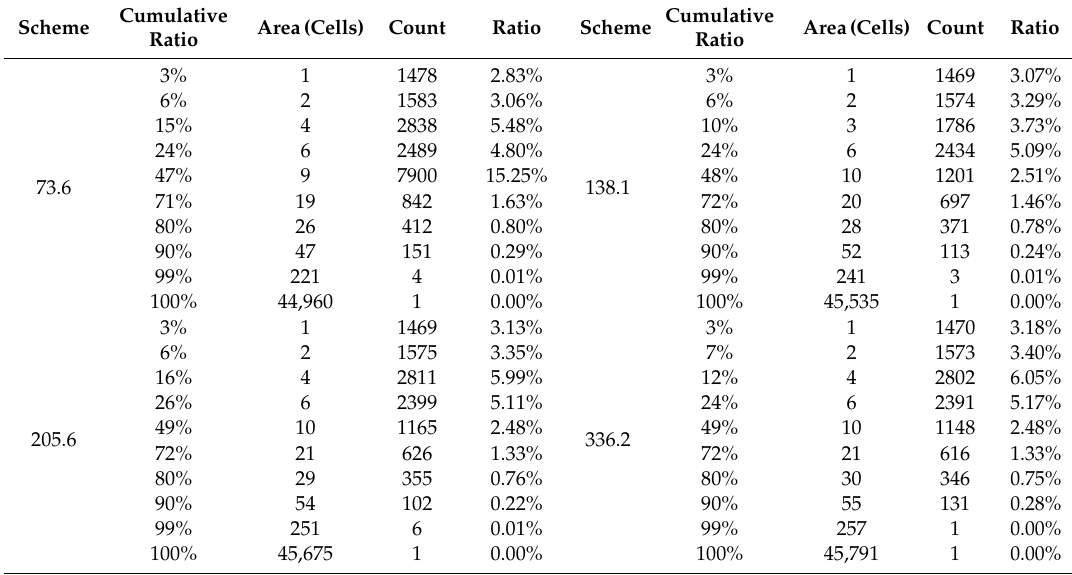
Table 3. The cumulative ratio of area in the four schemes of precipitation to divide basic units.